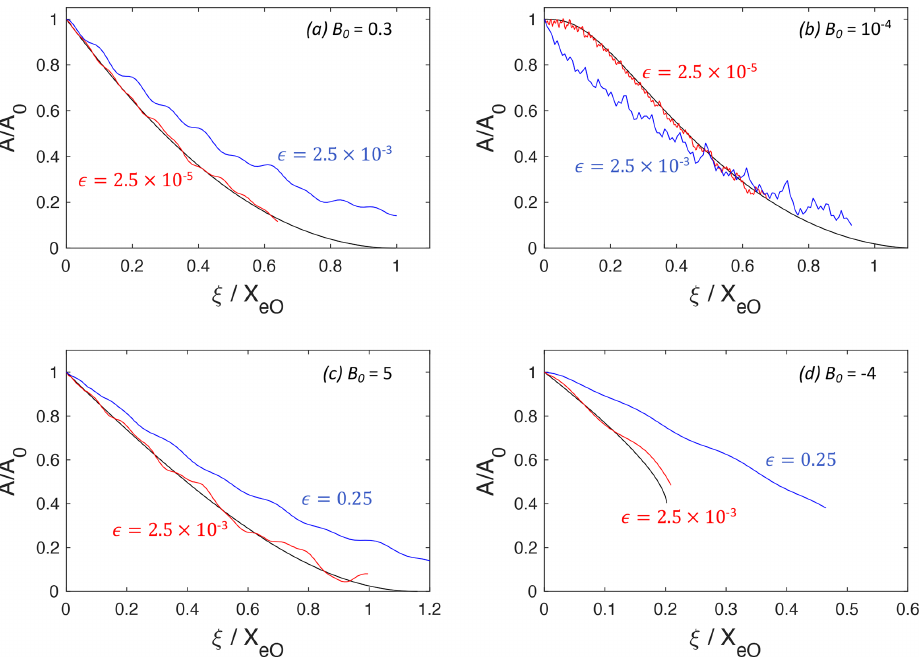
Figure 3. Comparison of the rG adiabatic radiation decay theory for homogeneous conditions (black lines) and rG numerical solutions for (a) B 0 = 0 . 3, (b) B 0 = 10 − 4 , (c) B 0 = 5, and (d) B 0 = − 4. In panels (a) and (b) , red (blue) indicates the numerical solutions of the rG equation (Eq. 30) for (cid:15) = 2 . 5 × 10 − 5 (2 . 5 × 10 − 3 ). In panels (c) and (d) , red (blue) indicates (cid:15) = 2 . 5 × 10 − 3 (0 .